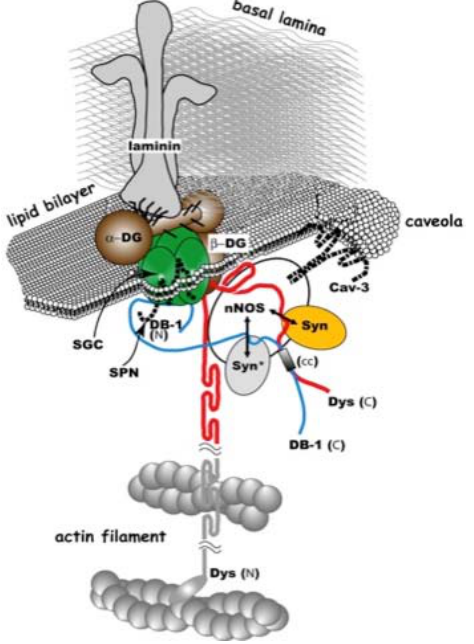
Figure 1. Dystrophin-glycoprotein complex. Molecular structure of the dystrophin- glycoprotein complex and related proteins superimposed on the sarcolemma and subsarcolemmal actin network (redrawn from Yoshida et al . [5], with modifications). cc, coiled-coil motif on dystrophin (Dys) and dystrobrevin (DB); SGC, sarcoglycan complex;SSPN, sarcospan; Syn, syntrophin; Cav3, caveolin-3; N and C, the N and C termini, respectively; G, G-domain of laminin; asterisk indicates the actin-binding site on the dystrophin rod domain; WW, WW